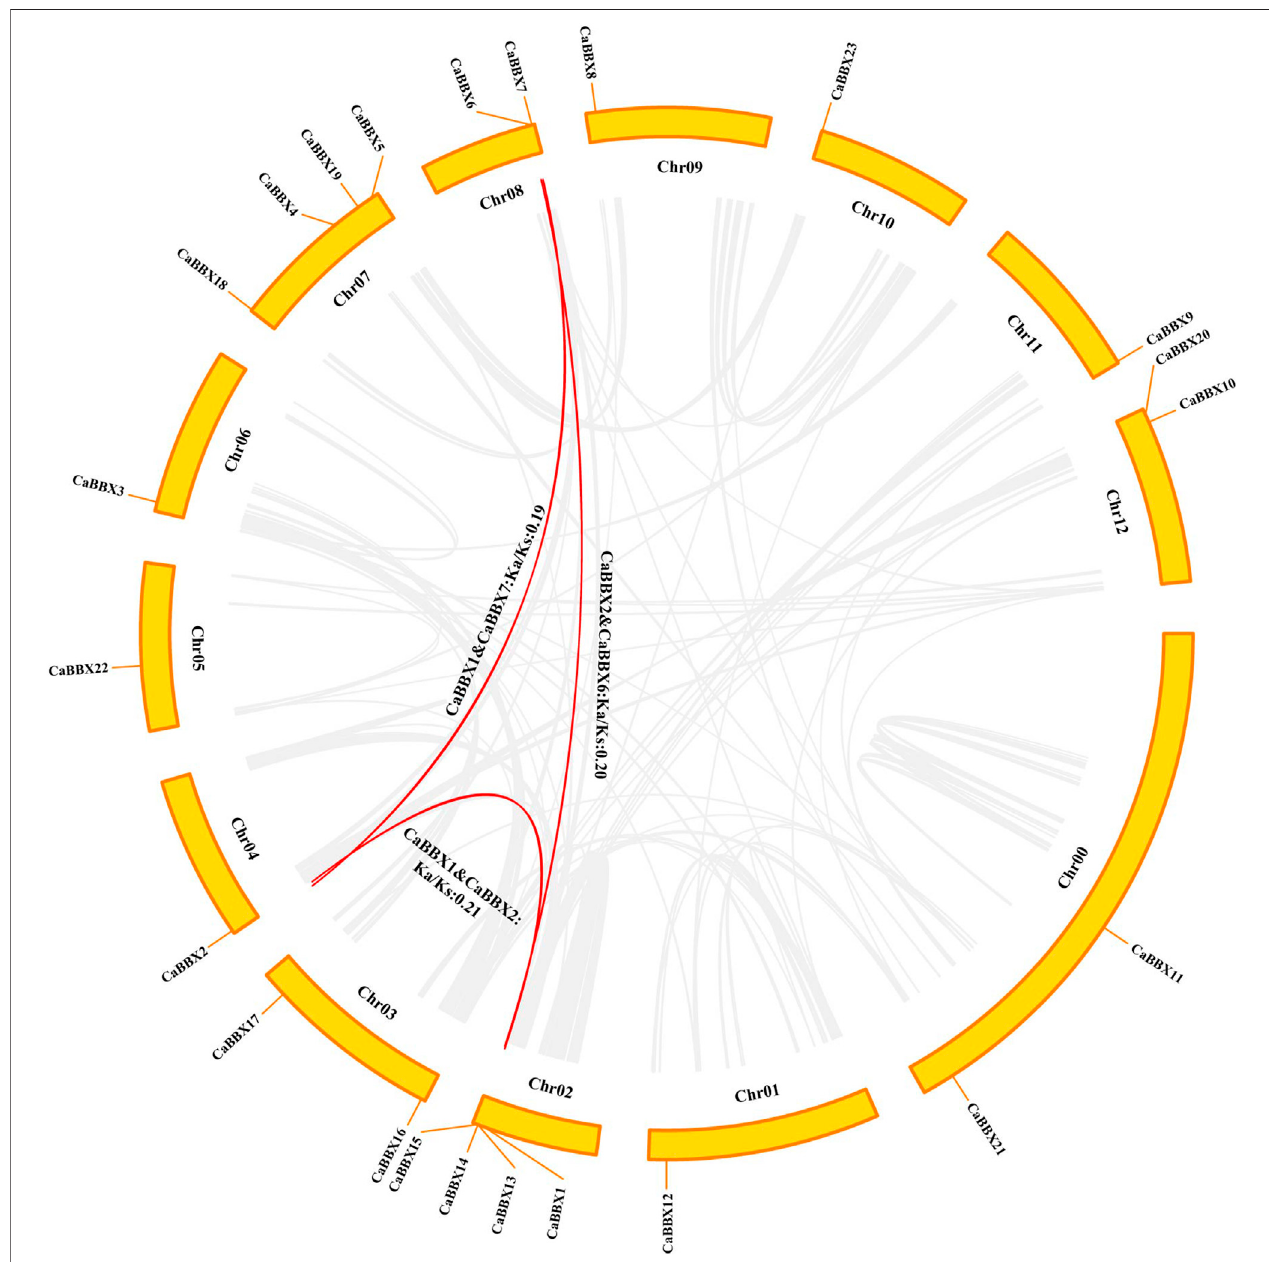
FIGURE 3 | Chromosomal location and interspecies gene synteny in CaBBX s. The chromosomal positions of CaBBX genes in the pepper genome. Red lines in the middle indicate duplicated gene pairs of CaBBX s. The positions of CaBBX genes in the pepper genome are marked on chromosomes; Chr refers to